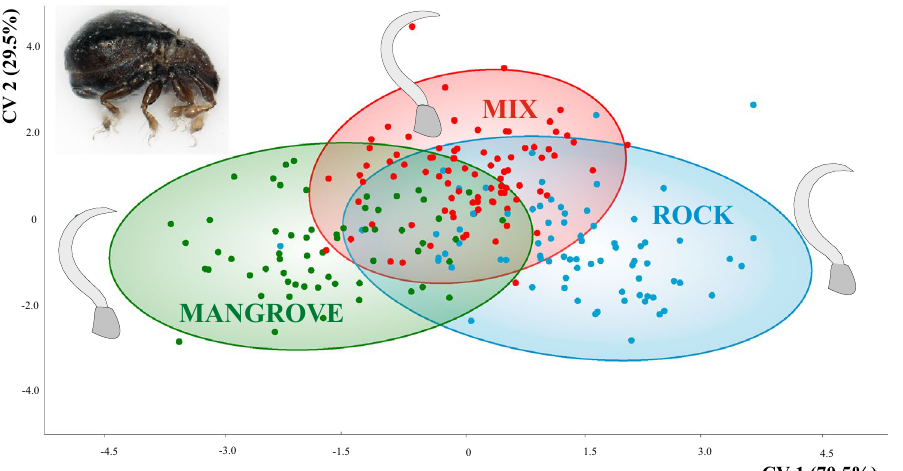
Figure 2. Mean claw shape in different habitats (rock, mix and mangrove). CVA scatter plot including every analyzed specimen. Lateral habitus of C. mangrovi shown in the upper left section of diagram.